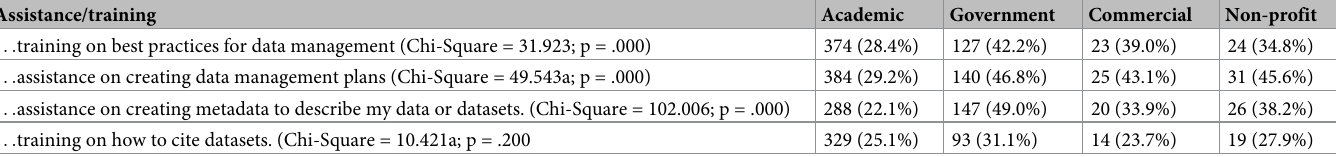
Table 4. Crosstab between “Primary sector of employment” and “My organization or project provides (training/assistance) ... ”.